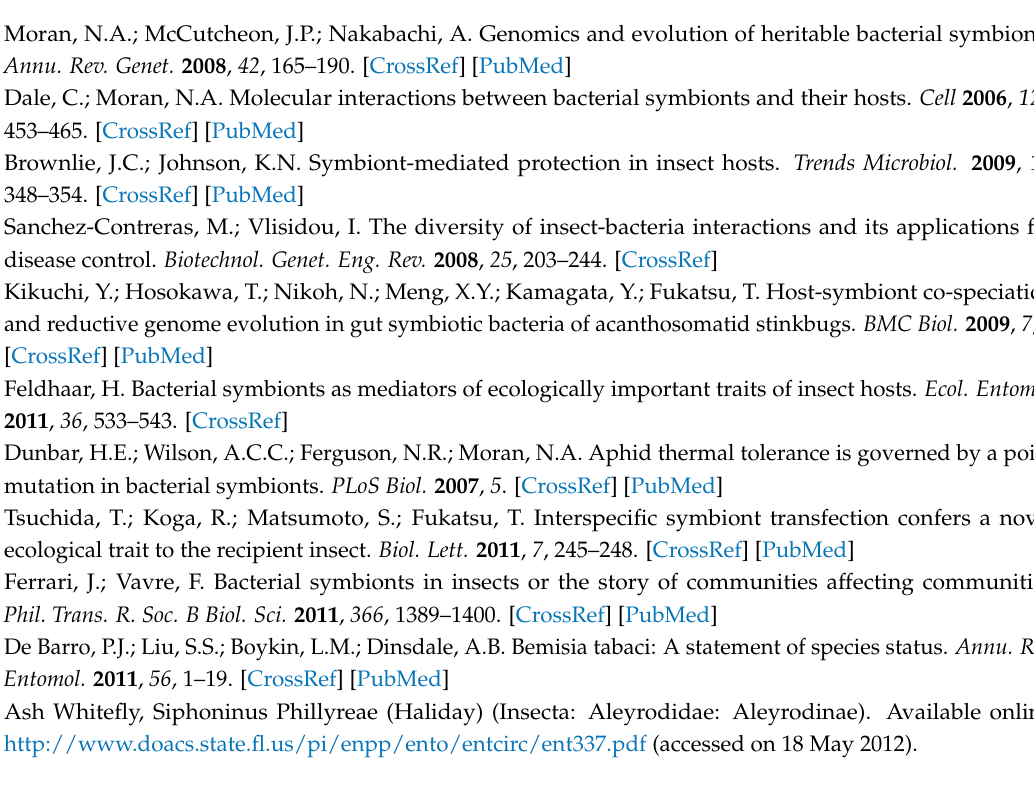
Figure S1: Individual and multiple infections by secondary bacterial symbionts in five B. tabaci and six T. vaporariorum populations from Croatia, Montenegro, Macedonia, and Serbia. Each square represents one population and each column represents one type of symbiont; the 20 rows per table represent the 20 individuals tested per population. Gray fields indicate positive infection for the tested symbiont. Population number, country and geographical location, species, and number of tested individuals are indicated at the top of each table. Symbionts: R— Rickettsia , H— Hamiltonella , A— Arsenophonus , W— Wolbachia , C— Cardinium ; Table S1. The whitefly populations used in this